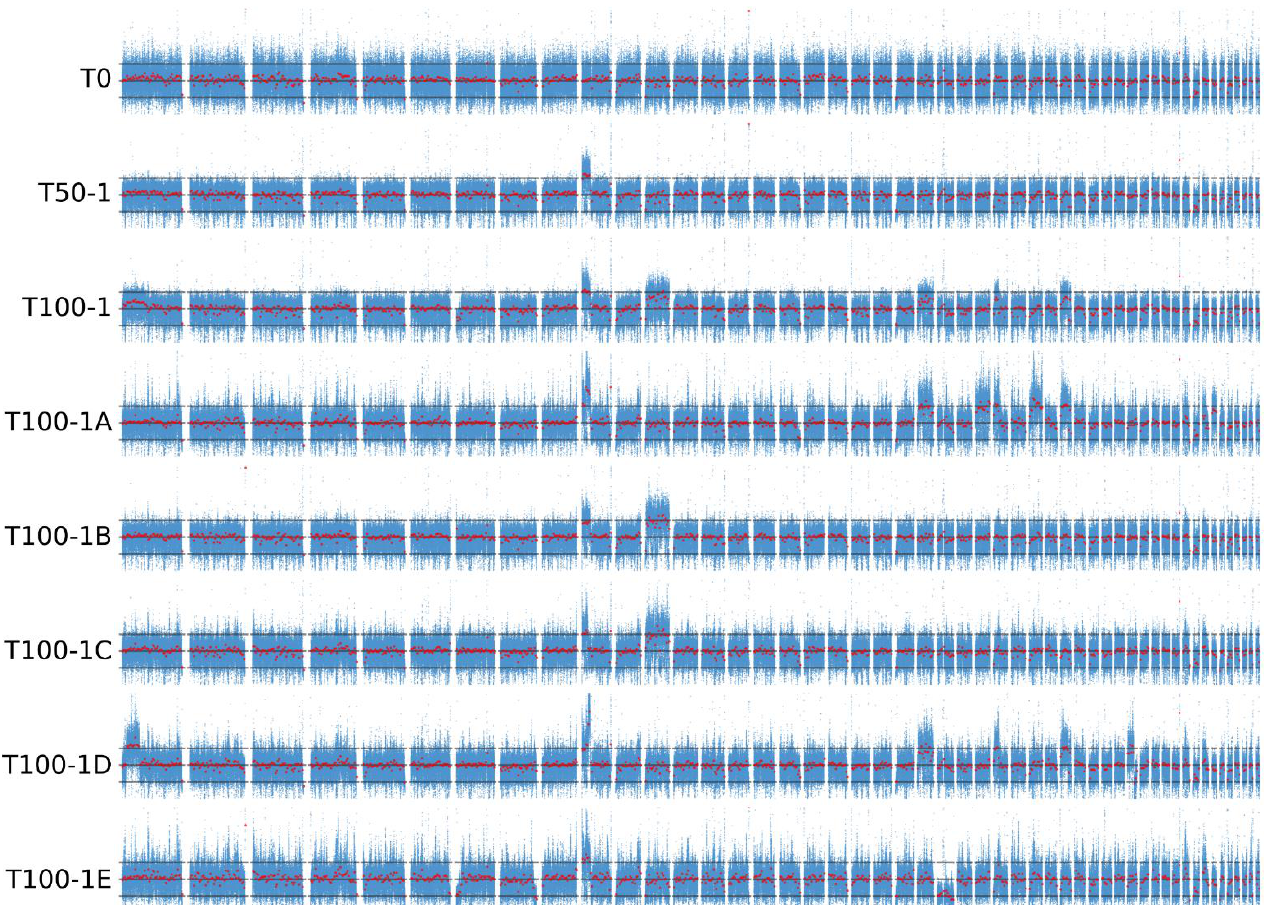
Figure 3. Sequencing coverage of the progenitor and evolved strains of Hortaea werneckii . Whole-genome sequencing reads were mapped to a haploid H. werneckii reference genome. The per-nucleotide sequencing depth was normalised by the median sequencing depth of the strain by subtracting the median from the per-nucleotide depth and dividing the result by the median. For the 50 largest contigs of the haploid reference genome, arithmetic mean coverage in 50 bp bins is shown in blue, overlayed by the median coverage in 30 kbp bins (red). Horizontal lines mark the values 0 (approximately expected coverage for diploid regions in a majority diploid genome), −0.5 (approximately expected coverage for haploid regions), and 0.5 (approximately expected coverage for triploid regions).